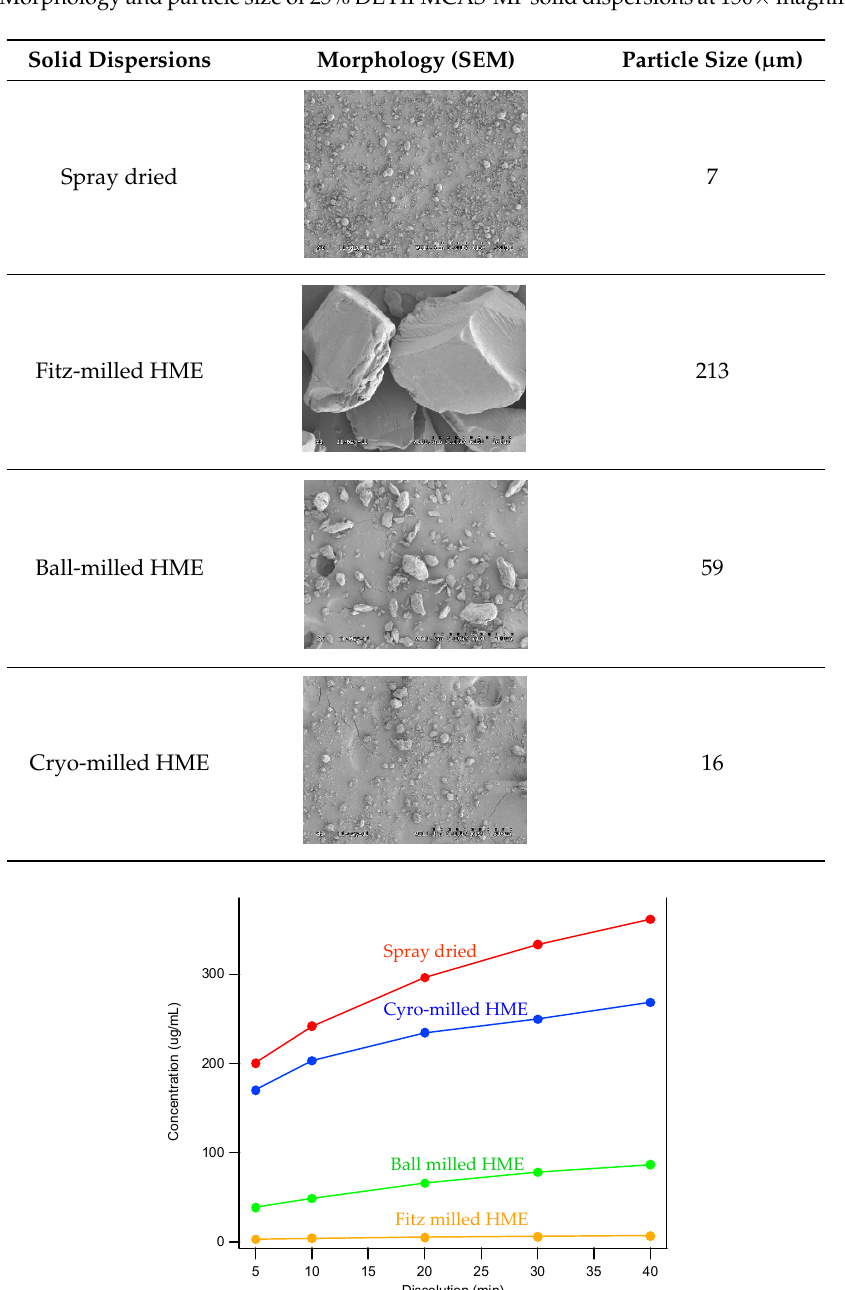
Figure 4. Dissolution profiles of SDD and milled HMEs in simulated gastric fluid (SGF).